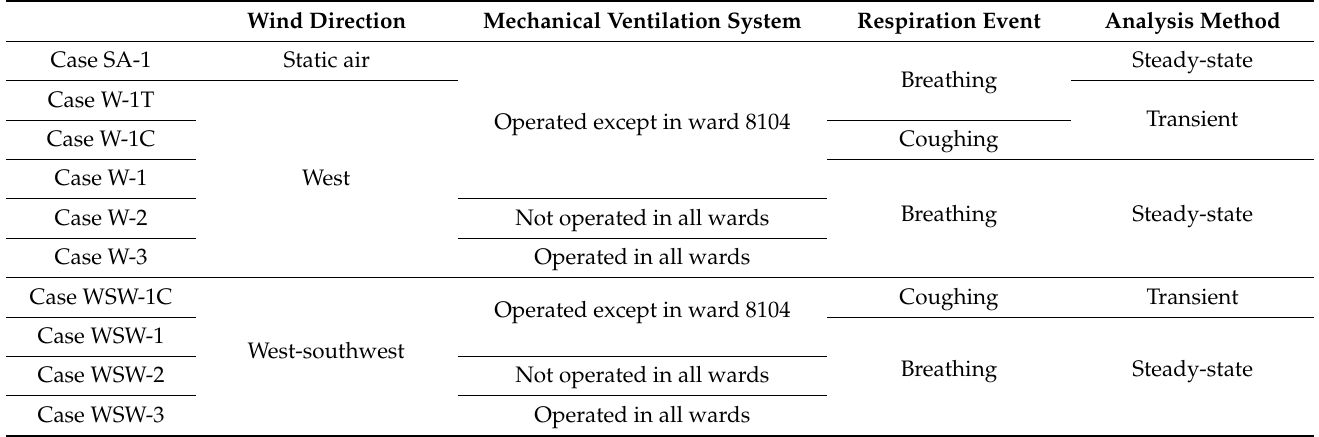
Table 1. CFD simulation